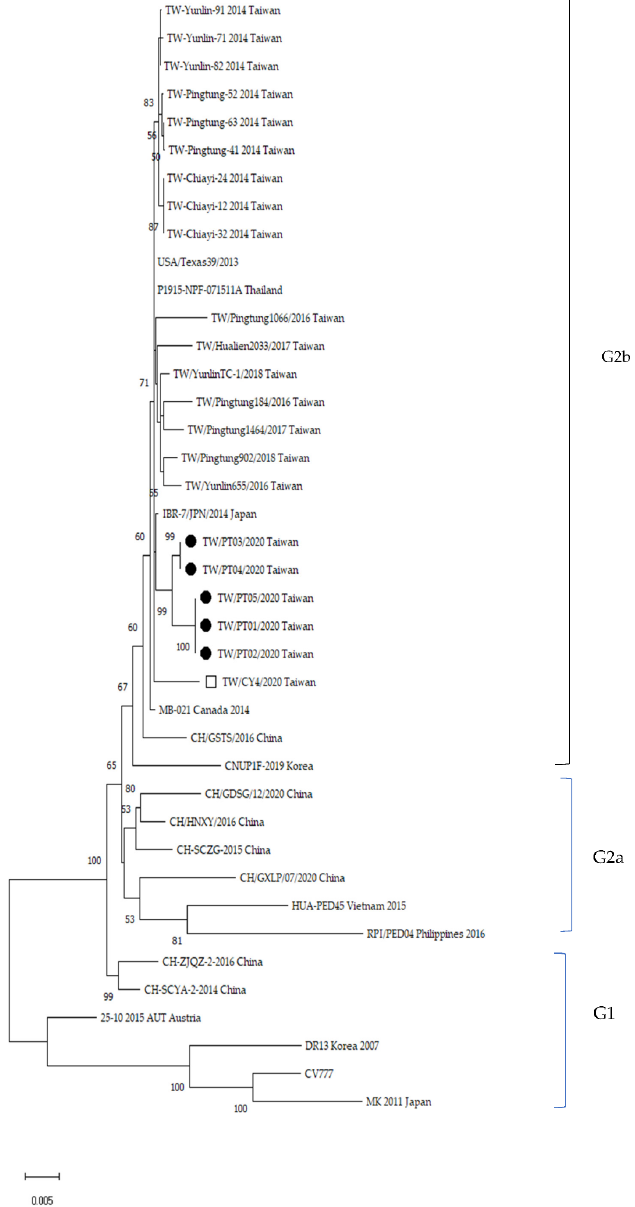
Figure 3. Phylogenetic tree of PEDV strains based on full-length spike gene generated by the Maximum Likelihood method with the Kimura two-parameter model, using the MEGA software. Bootstrapping with 1000 replicates was performed to determine the percentage reliability for each internal node. Horizontal branch lengths were correlated to genetic distances among PEDV strains, with different genogroups labeled on the right. Black solid circles represent PEDV strains isolated from the SL farm that used feedback. The hollow square represents CY4 strains isolated from the CL farm with no feedback. The scale bar represents nucleotide substitutions per